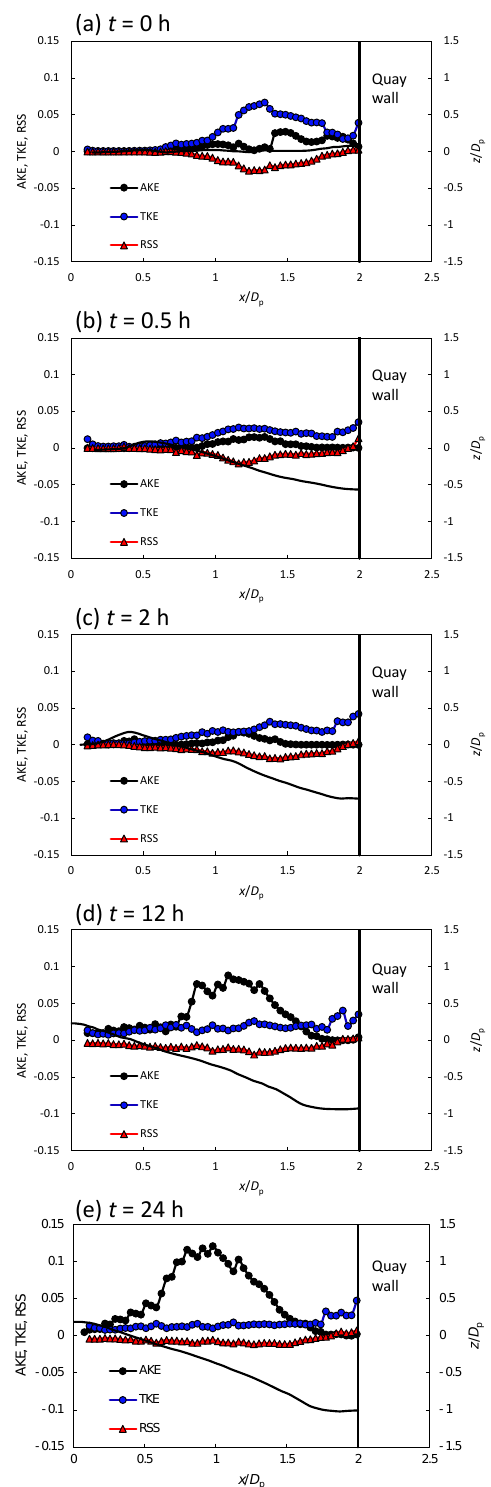
Figure 9. Comparison of AKE, TKE, RSS distributions along the developing scour bed at X w = 2 D p : ( a ) t = 0 h; ( b ) t = 0.5 h; ( c ) t = 2 h; ( d ) t = 12 h; ( e ) t = 24 h.